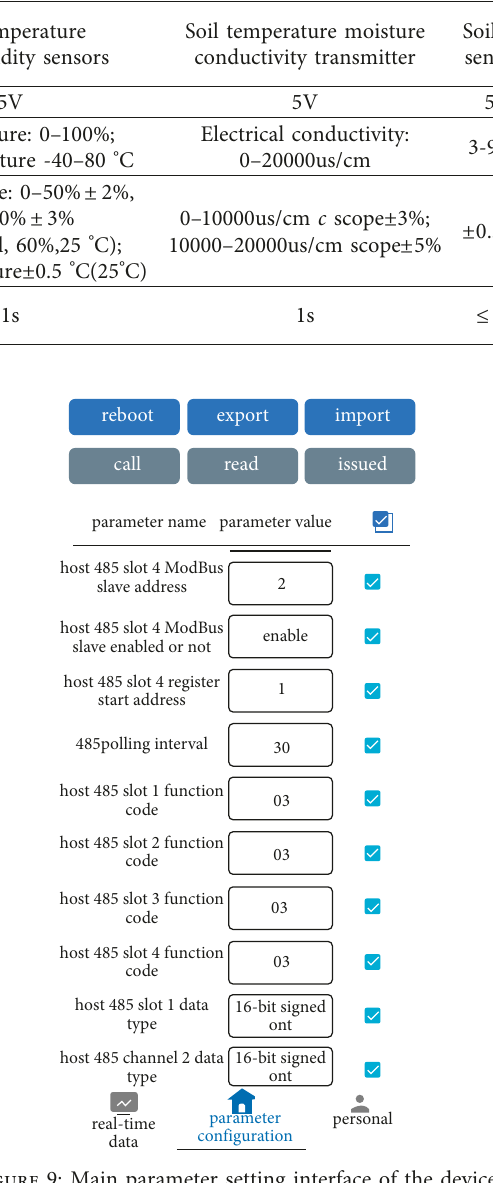
Table 3: Related sensor performance indicators.